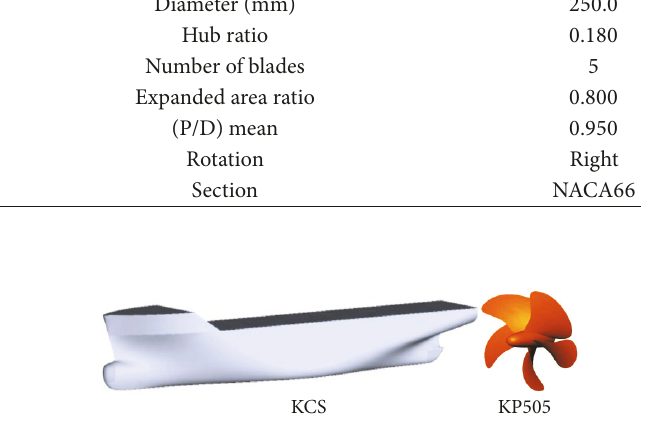
Figure 1: Geometrical model of the KCS hull and the propeller